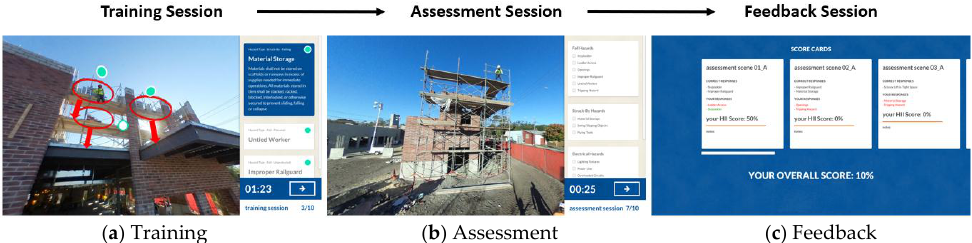
Figure 4. Hazard-Recognition Sessions: ( a ) Training, ( b ) Assessment, and ( c ) Feedback.